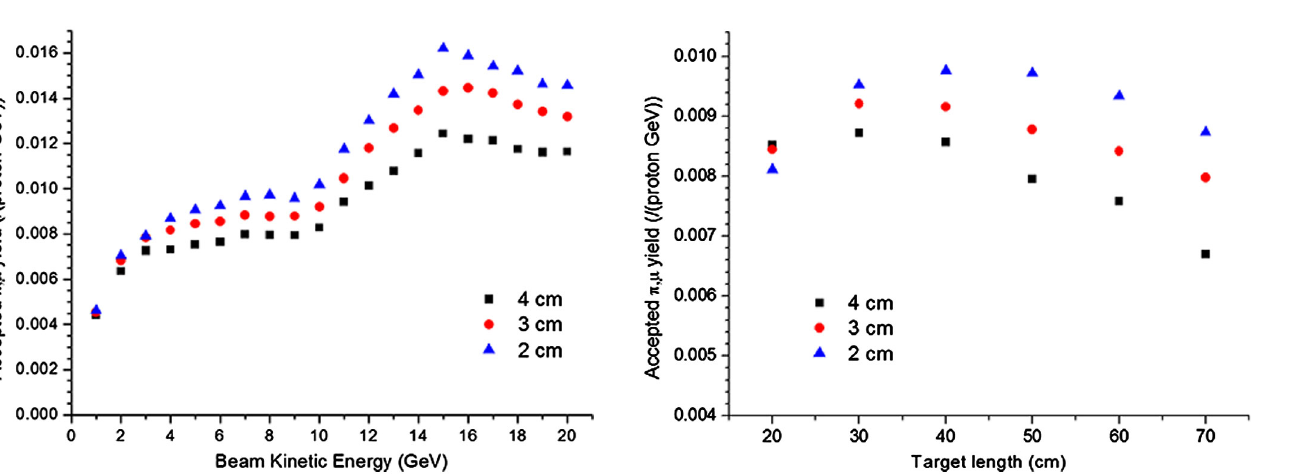
FIG. 9. Desired (pions and) muons yields (per proton per GeV) for different target widths for the neutrino factory as a function of beam energy.